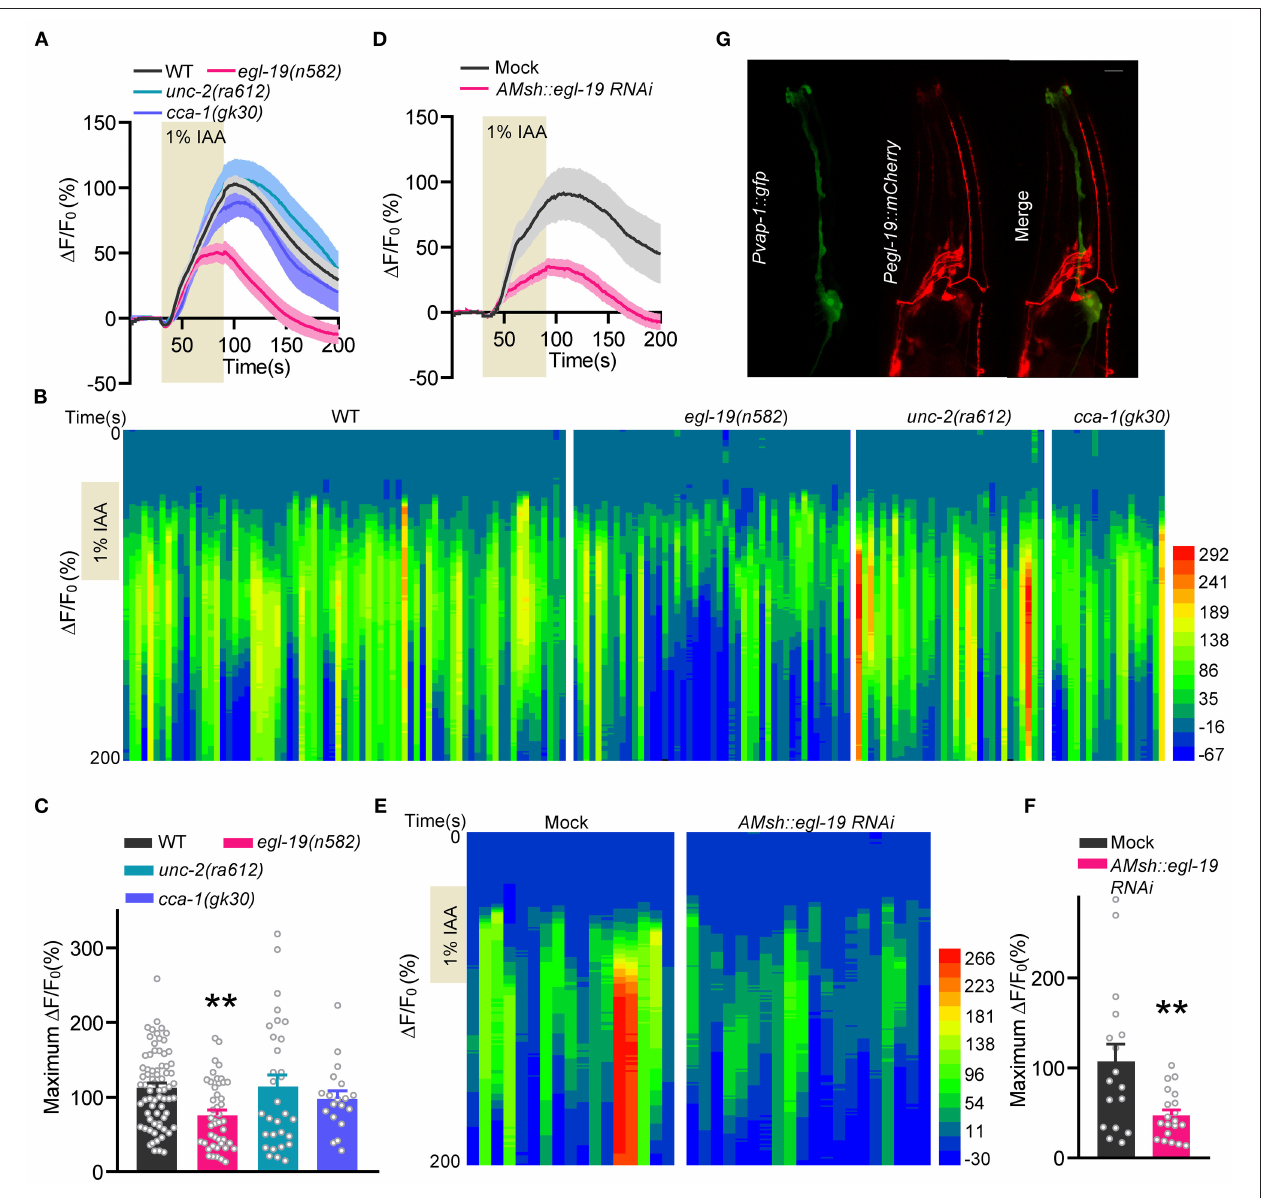
FIGURE 1 | EGL-19 is involved in IAA-evoked Ca 2 + increases in AMsh glia. (A–C) IAA (1/100)-evoked calcium increases of AMsh glia in wild type, egl-19(n582) mutants, unc-2(ra612) mutants, and cca-1(gk30) mutants. (A) Calcium responses. Note that the solid lines show the average fluorescence changes and the shading indicates SEM. (B) Heat map of calcium responses. (C) Maximum 1 F/F 0 changes. IAA were dissolved 1:1 in DMSO as stock solution and then diluted in the bath solution to a final concentration of 1:100 before use. 1 F and F 0 are defined as the fluorescence changes after IAA addition and the average fluorescence intensity from the last 10s before IAA addition, respectively. Wild type (ST1071), n = 70; egl-19(n582) (ST2889), n = 45; unc-2(ra612) (ST2990), n = 31; cca-1(gk30) (ST2991) , n = 29; unpaired t -test. (D–F) Specific knockdown of egl-19 in AMsh glia led to defective AMsh glial calcium increases in response to IAA (1/100). (D) Calcium responses. (E) Heat map of calcium responses. (F) Maximum 1 F/F 0 changes. Mock (ST2674), n = 17; AMsh egl-19 RNAi (ST2729) , n = 20; unpaired t -test. (G) The co-localization of Pegl-19::mCherry with Pvap-1::GFP supports that EGL-19 is expressed in AMsh glia. Scale bar, 10 µ m Error bars represent SEM. ** p < 0.01.